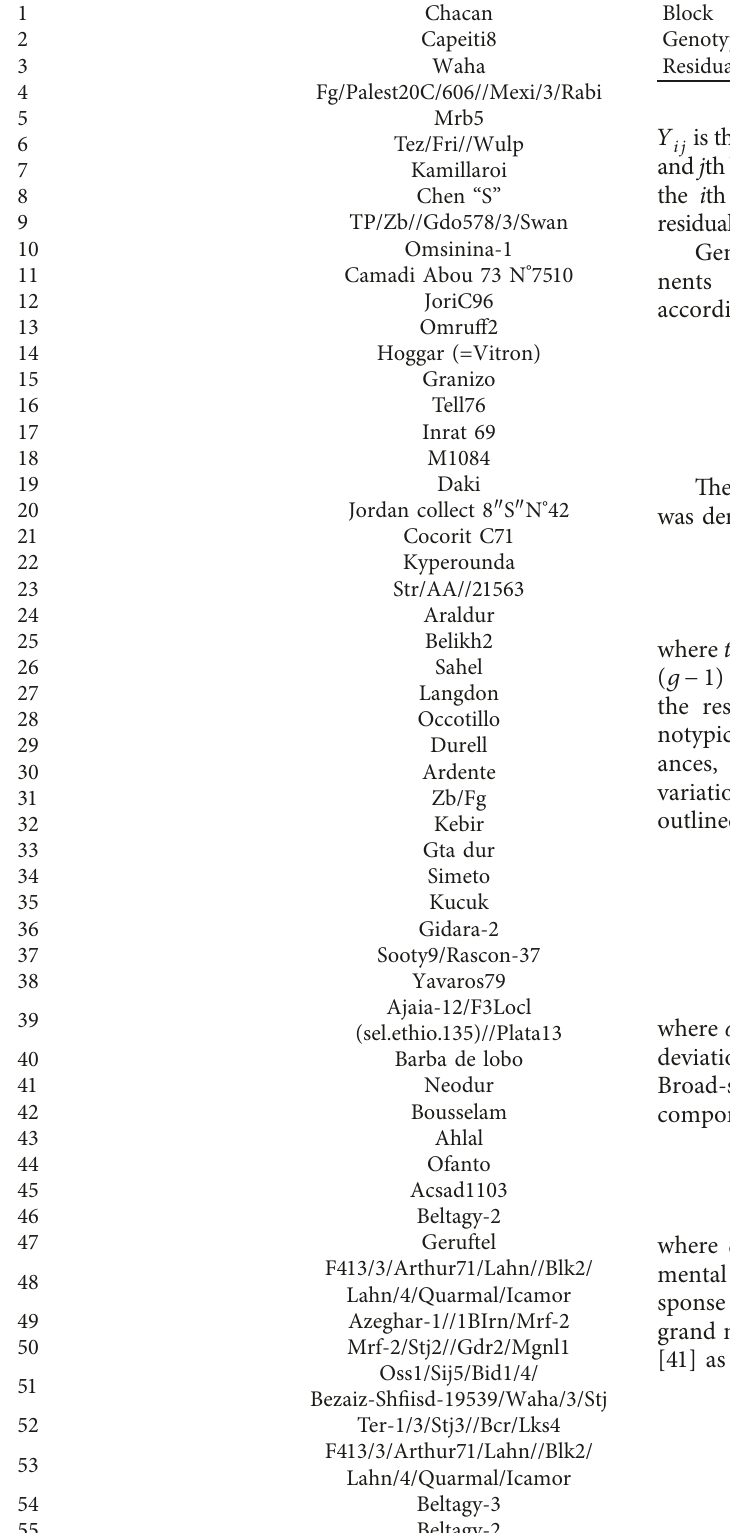
2015 at the INRAA-ITGC-ARS, El-Khroub,